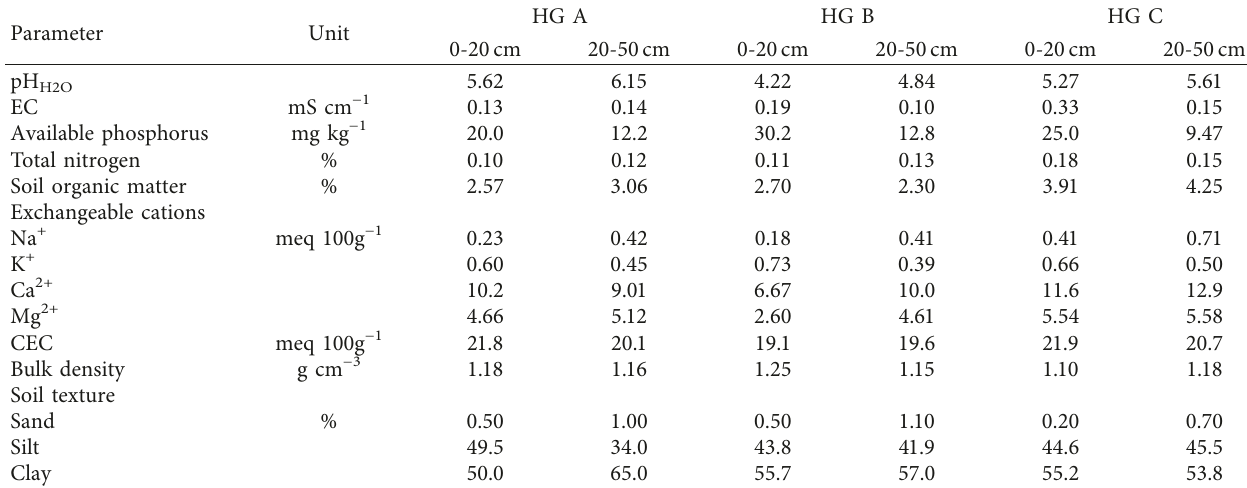
Table 1: Initial physicochemical properties of the experimental